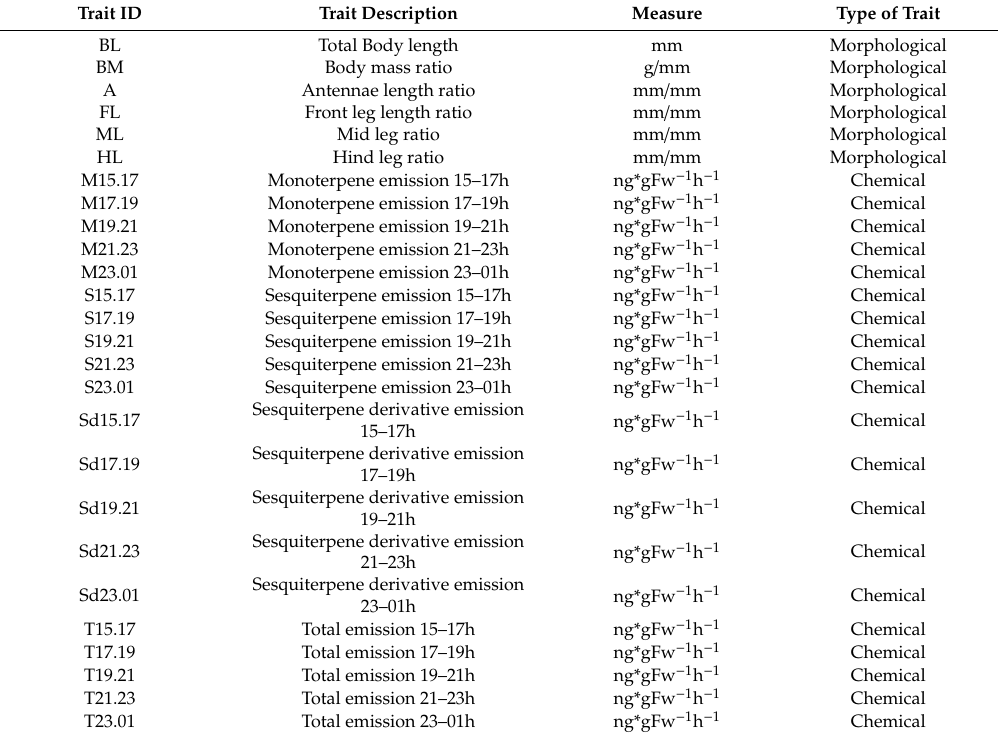
Table 1. Morphological and chemical traits measured in this study of stick